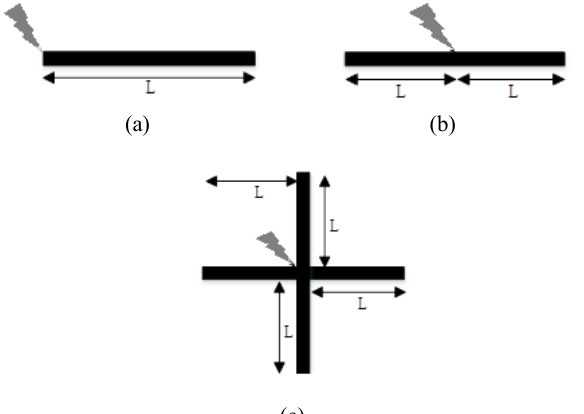
Figure 1: Different arrangements of horizontal electrodes under lightning current. (a): corner-injected one-arm electrode, (b):center-injected two-arm electrode, (c): center- injected four-arm electrode .